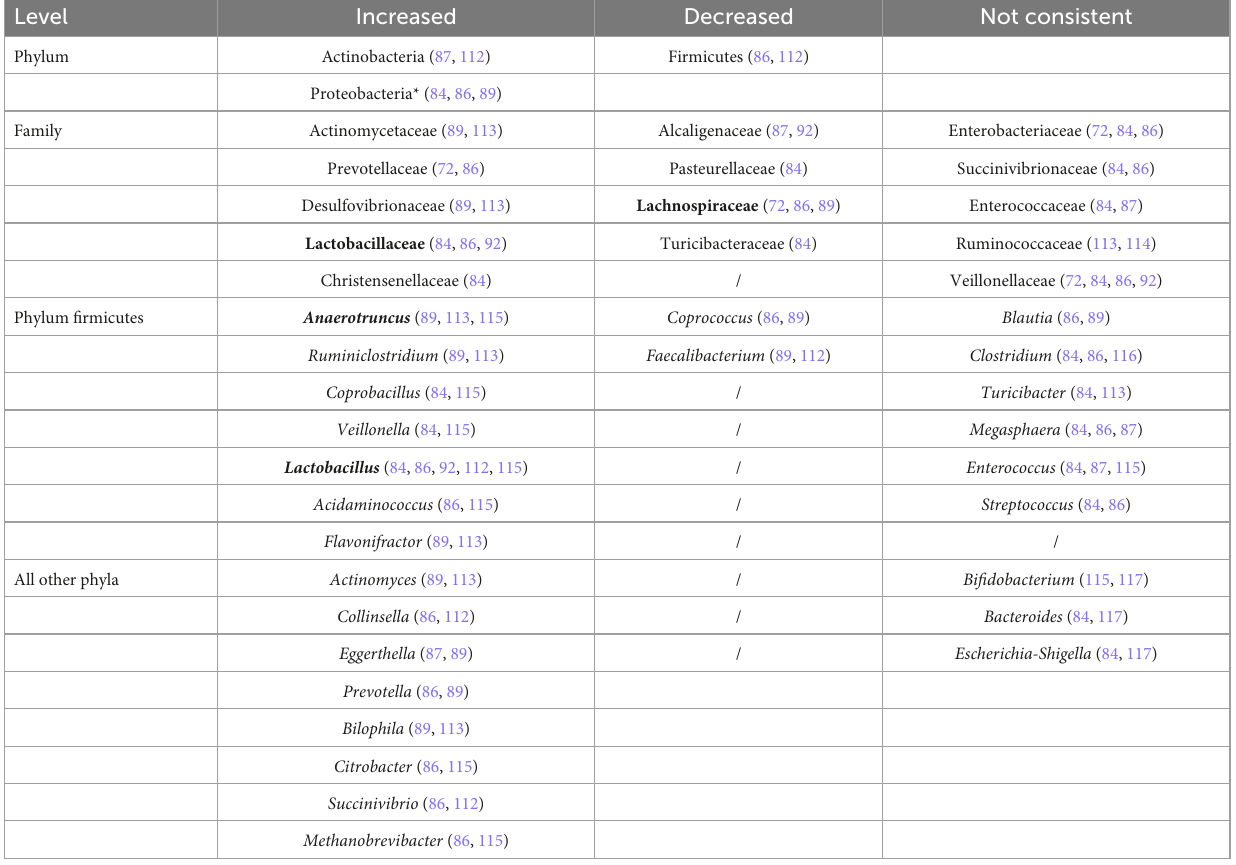
TABLE 1 Significant changes in relative abundance of microbial taxa in